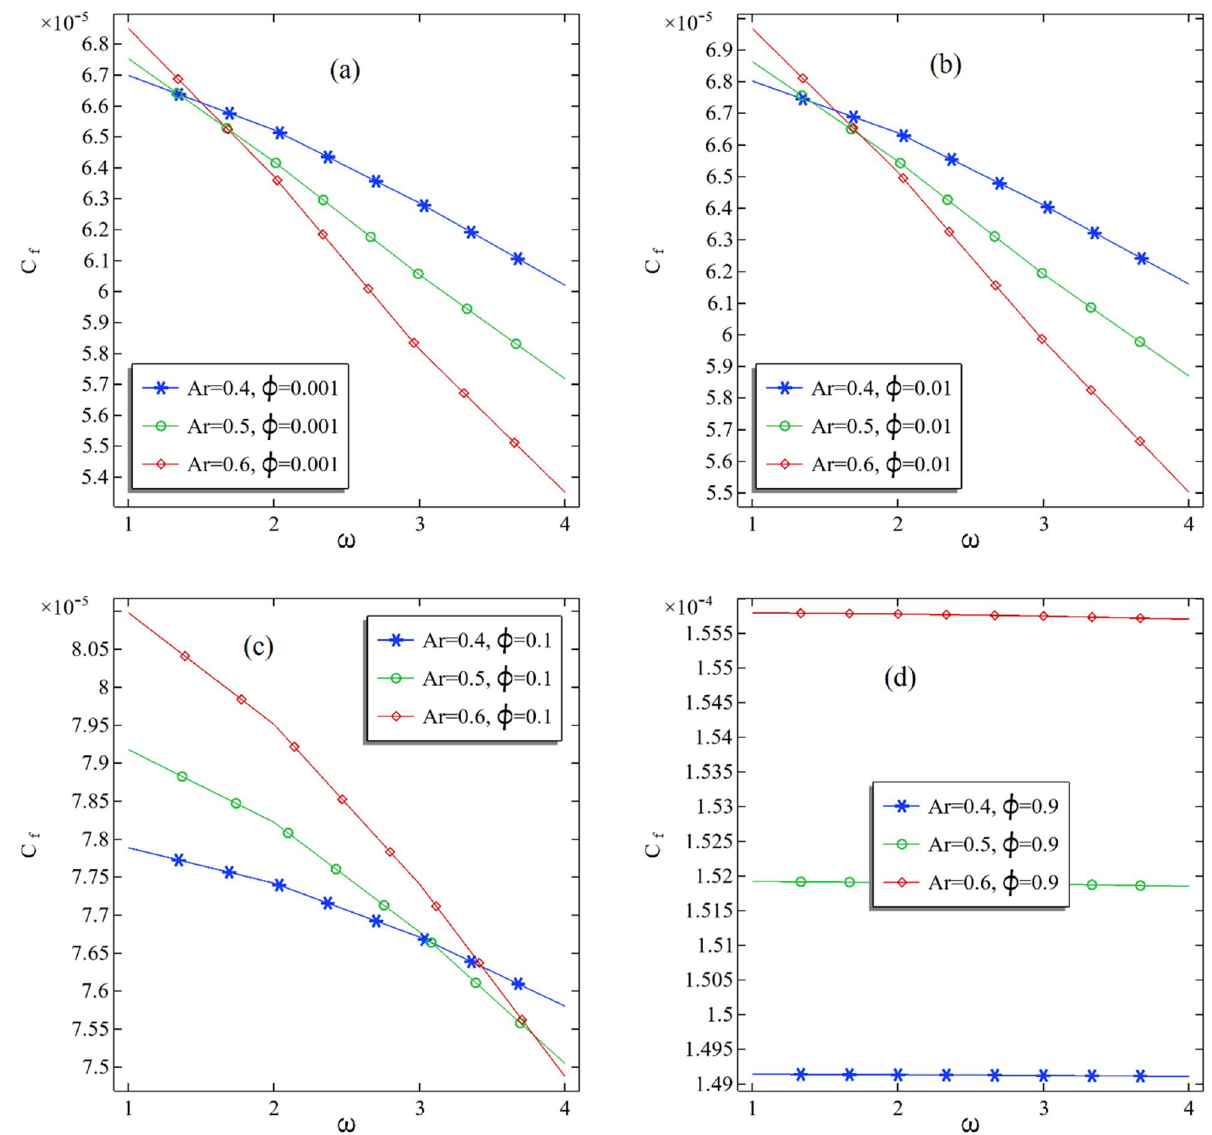
Figure 11. ( a – d ): The average skin friction coefficient at the middle of the annular with increasing rotational speed of the inner